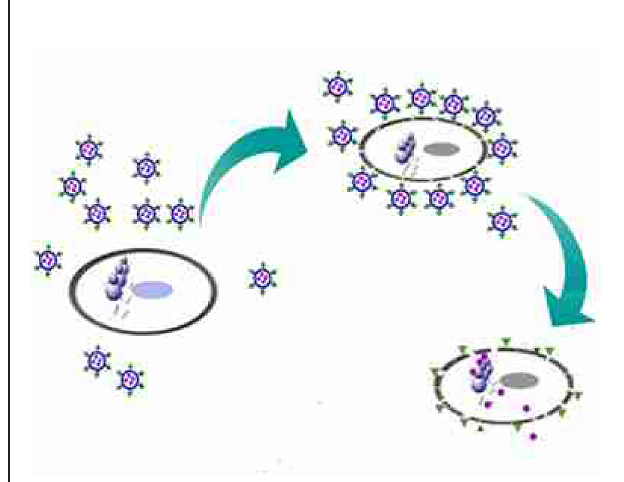
FIGURE 9 | Schematic representation of Ts-LPs-LEV killing bacteria process. Briefly, when Ts-LPs-LEV co-incubated with the bacteria, Ts carried a large amount of levofloxacin-loaded liposomes to the bacterial surface and anchored in the outer membrane by combination with LPS and/or negatively charged components. Then, the liposomes fused with the bacterial cell outer membrane, which could enhance levofloxacin entry through hydrophobic and/or self-promoted pathway or contact release. Meanwhile, Ts perturbed the membrane lipid bilayers of the bacteria and removed the electrical potential of the membrane, affecting the activity of the drug efflux pumps and thus resulting in an intra-bacterial levofloxacin accumulation. The cells finally became dead and